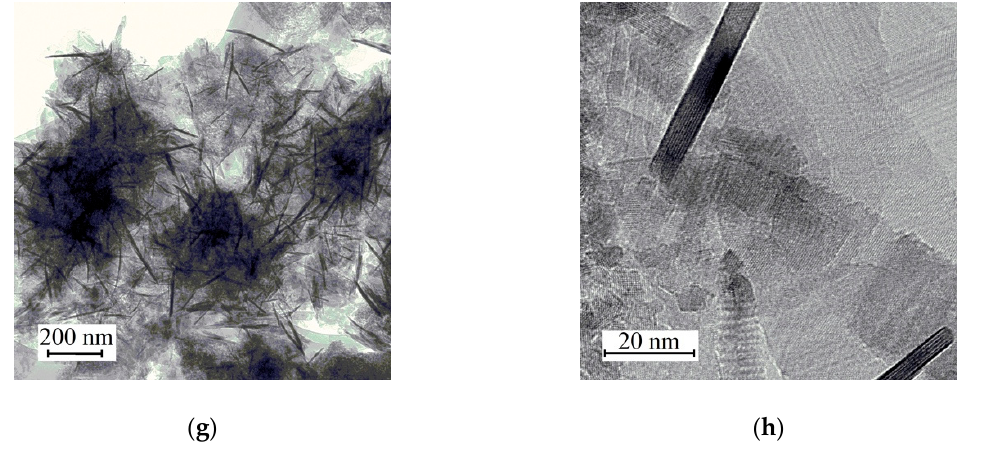
Figure 3. Scanning electron microscopy (SEM) ( a , c , e ) and transmission electron microscopy (TEM) ( b , d , f – h ) images of LTO ( a , b ), LTO/5%G_157M ( c , d ), LTO/5%CB ( e , f ), and LTO/5%CR ( g , h ).